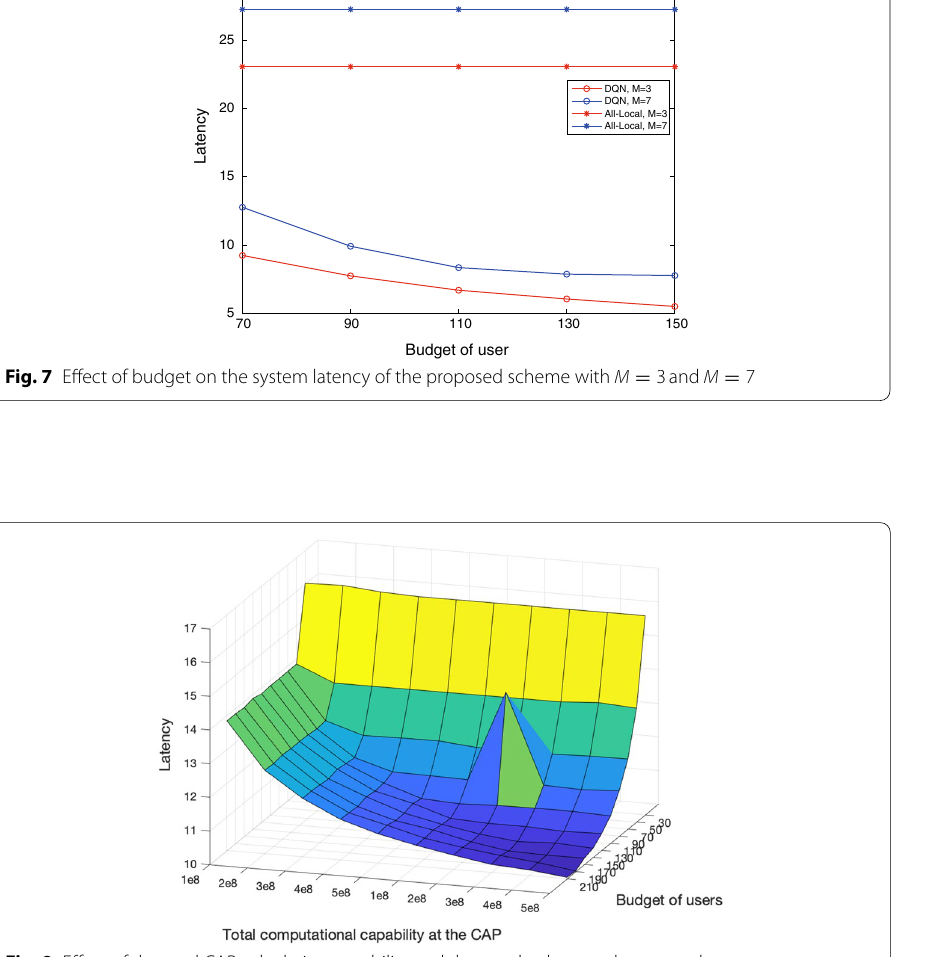
Fig. 8 Effect of the total CAP calculating capability and the user budget on the system